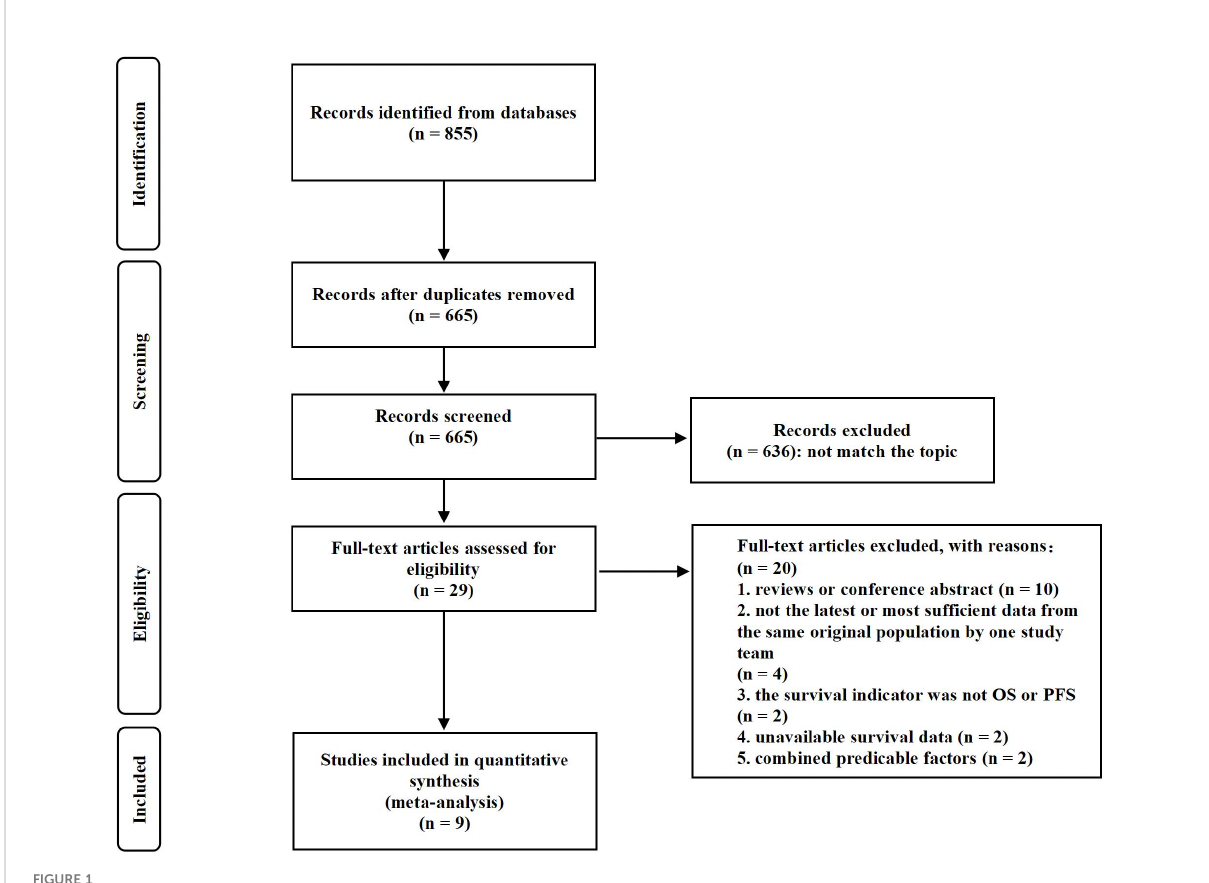
FIGURE 1 Flow diagram of study